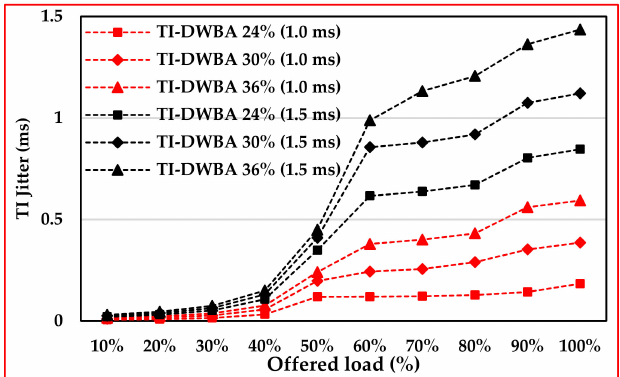
Figure 8. TI Jitter 1.0 (ms) and 1.5 (ms) cycle time.